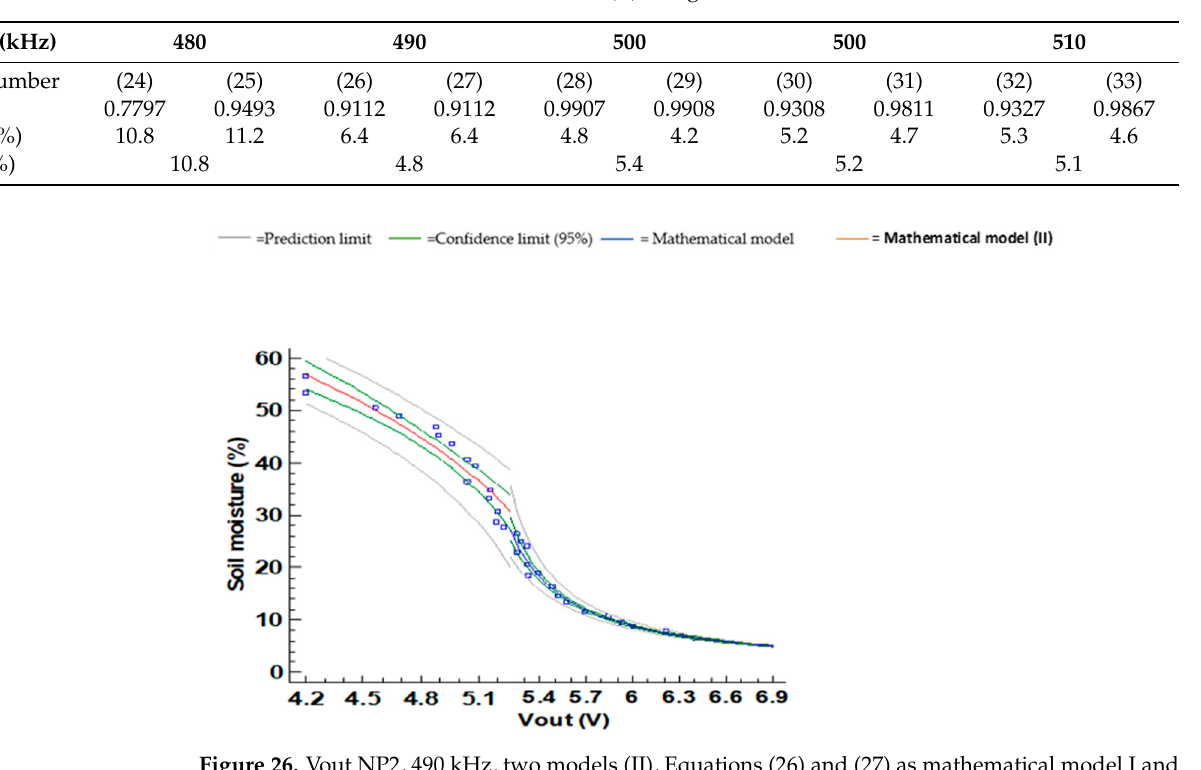
Table 10. Values of R2 and REs in NP2 (II) using two models.